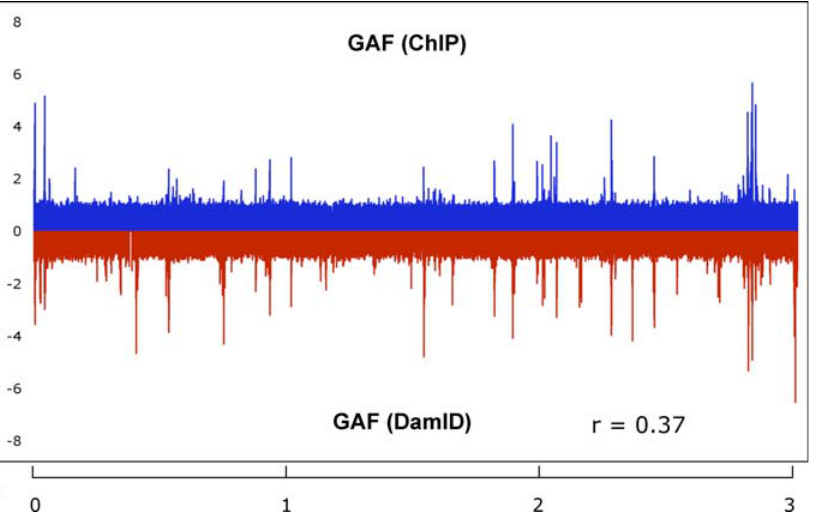
Figure 1. Evaluation of the ChIP Quality Comparison of protein mapping using ChIP versus DamID. The graph represents the FC of GAF binding on the Adh region obtained by ChIP at the embryonic stage (upper panel in blue) and with DamID in cultured Kc cells as described in [40] (lower panel in red). Pearson’s correlation coefficient between the two distributions is indicated at the bottom of the graph. DOI: 10.1371/journal.pbio.0040170.g001